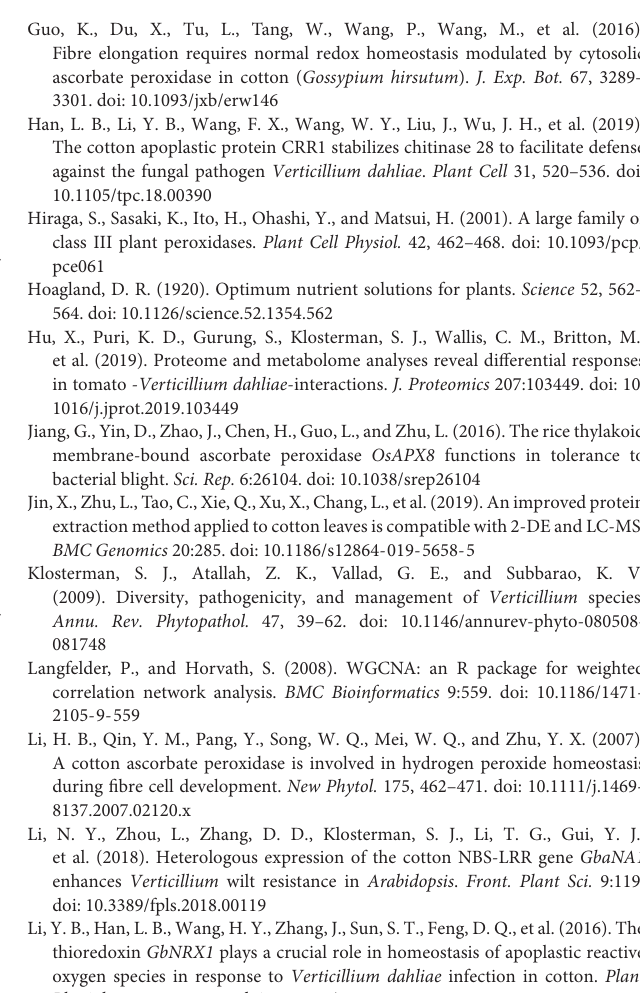
Supplementary Table 1 | Primers used in this work. Supplementary Table 2 | Detailed information for the 885 DAPs. Supplementary Table 3 | Detailed information for the 184 XH21-specific